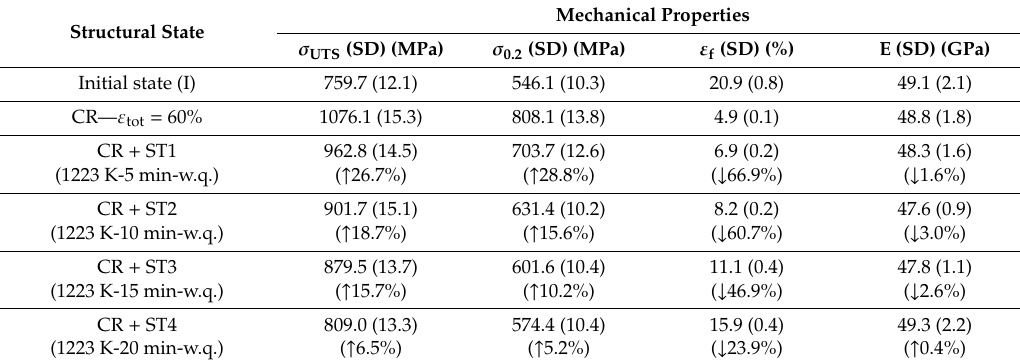
Figure 11. ( a – c ) SEM images of the sample processed by SPD-MPR ( ε tot = 60%) corresponding to the 2nd direction of the TMP Program ( a , b , c —same sample, with gradual increasing magnifications).